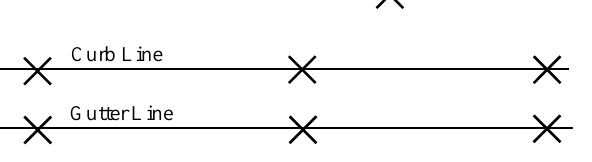
LiDAR sensor. While scanning data, areas that are measured